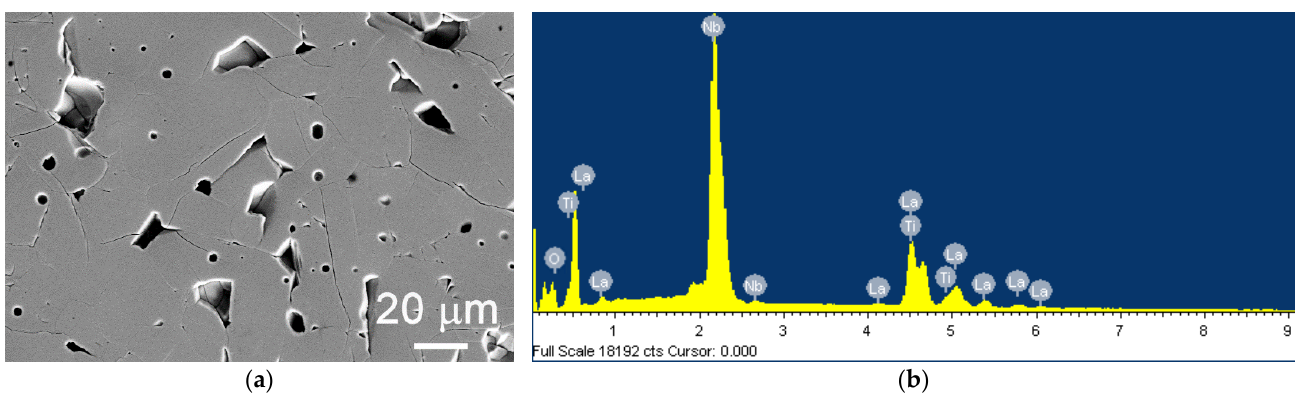
Figure 1. ( a ) FESEM micrograph of the single phase ceramic based on the composition correspond- ing to La 2.96 Ti 4.88 Nb 9.92 O 39 , sintered at 1300 °C, and ( b ) graph of the EDS analysis of the ceramic. to La 2.96 Ti 4.88 Nb 9.92 O 39 , sintered at 1300 ◦ C, and ( b ) graph of the EDS analysis of the ceramic.